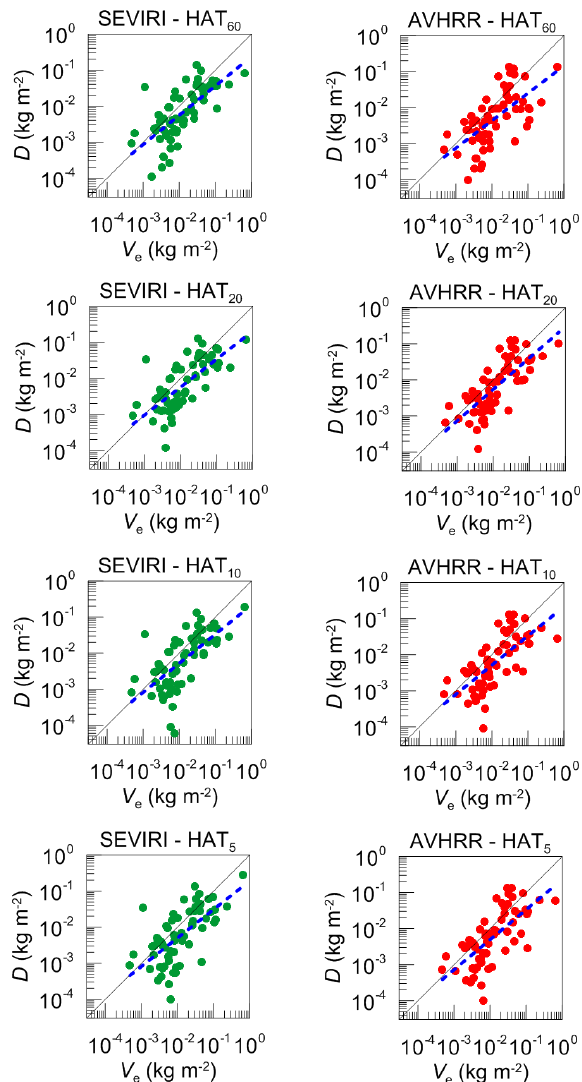
Figure 12. The absolute difference D between the ground-based and the satellite measurements of LWP as a function of the value of LWP variability estimate V e (see text). The data refer to the WH season. Dashed blue lines show the fit of the form ln( D ) = B ln( V e ) + A